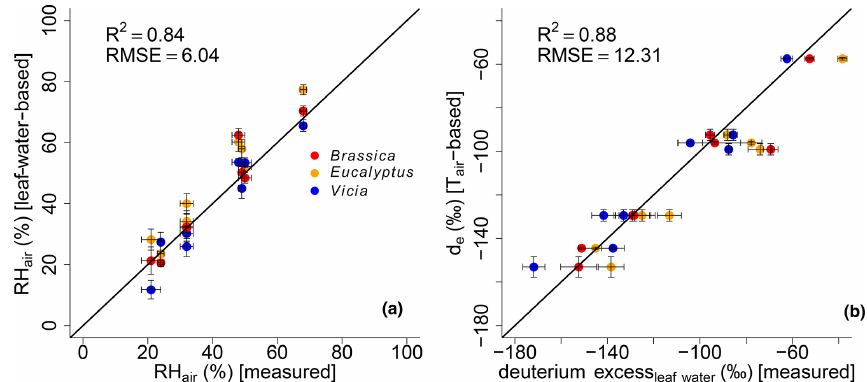
Figure 7. Scatterplots illustrating the correlation between (a) modeled (leaf-water-based) and measured air relative humidity (RH air ) and modeled ( T air -based) vs. measured leaf water deuterium excess. Black lines indicate the 1:1 relationship. R 2 and RMSE are calculated as described in Sect. 2.4, while the RMSE values have the dimensions of the respective variables. Error bars for the measured RH values represent analytical standard deviations (see Mayr, 2002). See Sect. 2.4 for the uncertainties in the calculated and modeled results.